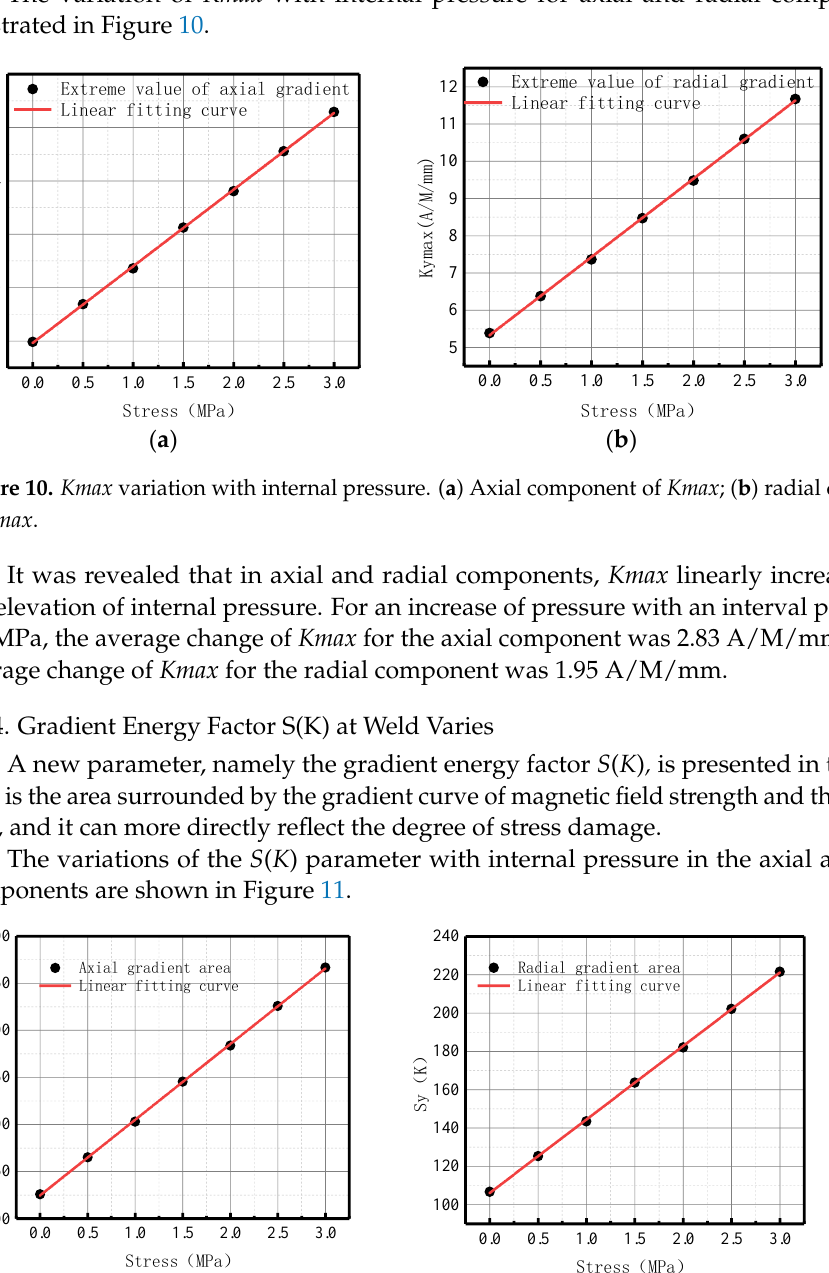
Figure 9. Magnetic signal gradient K variation with internal pressure. ( a ) The axial gradient compo- nent Kx; ( b ) the radial gradient component Ky.